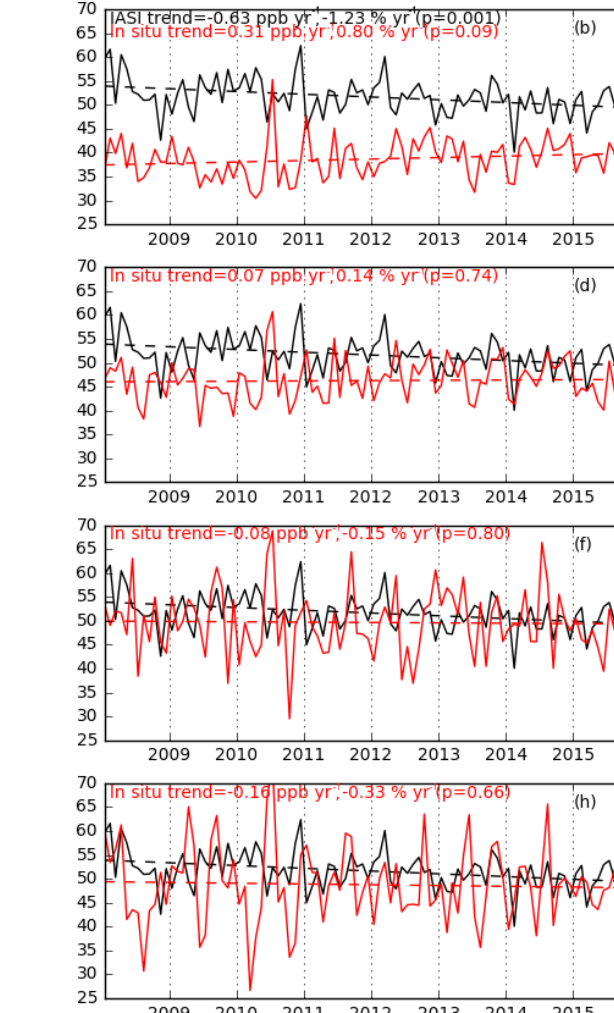
Figure 9. Evolution of the time series (deseasonalized or not deseasonalized) when changing the sampling. The IASI equivalent column concentrations are plotted in black, and the surface concentrations measured at Shangdianzi station, China, are plotted in red.